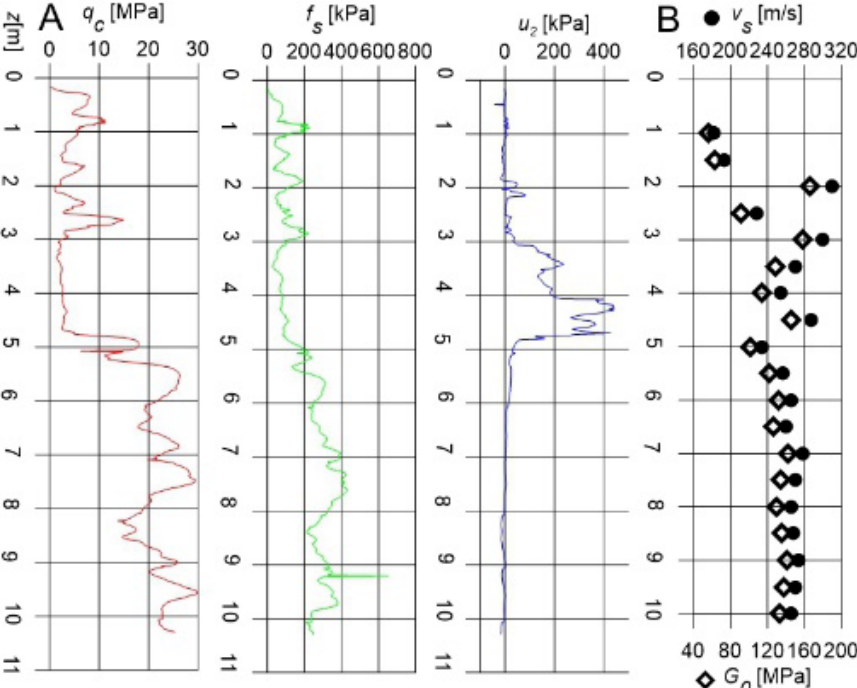
Figure 4: The example CPTU profile ‘A’ and SDMT results ‘B’ at Derkacze test